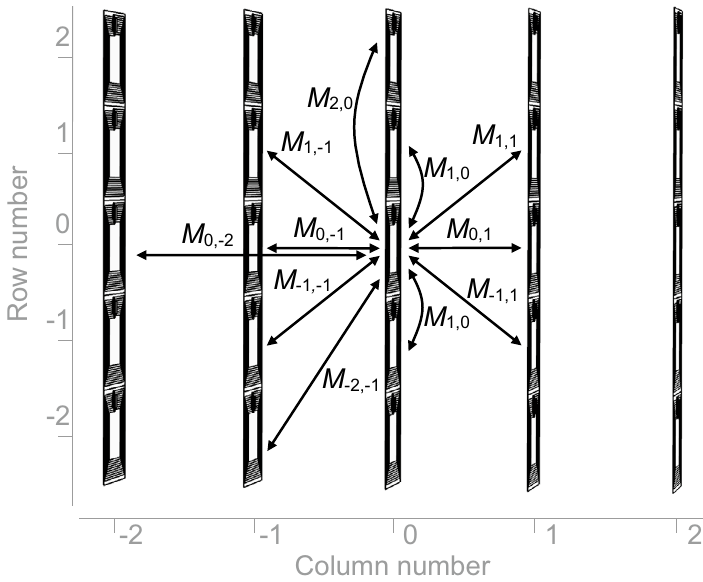
Figure 3. Front view on the periodic structure of resonators with indicated mutual inductances between considered unit cell and other cells in the